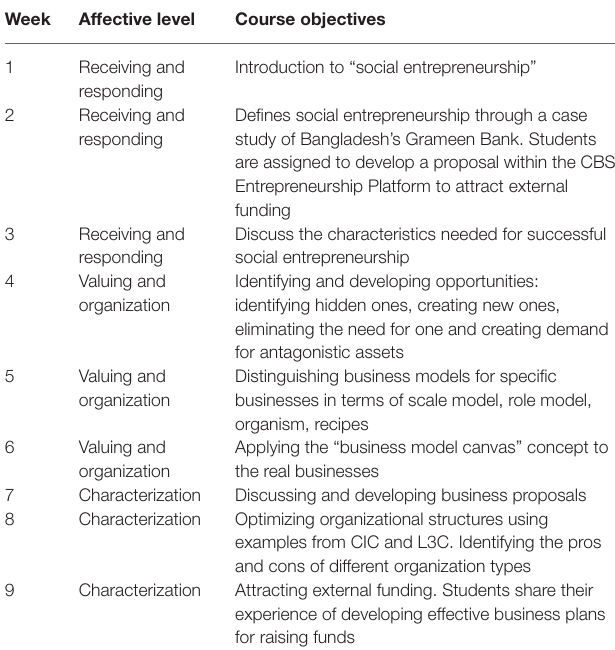
TABLE 1 | Entrepreneurship course